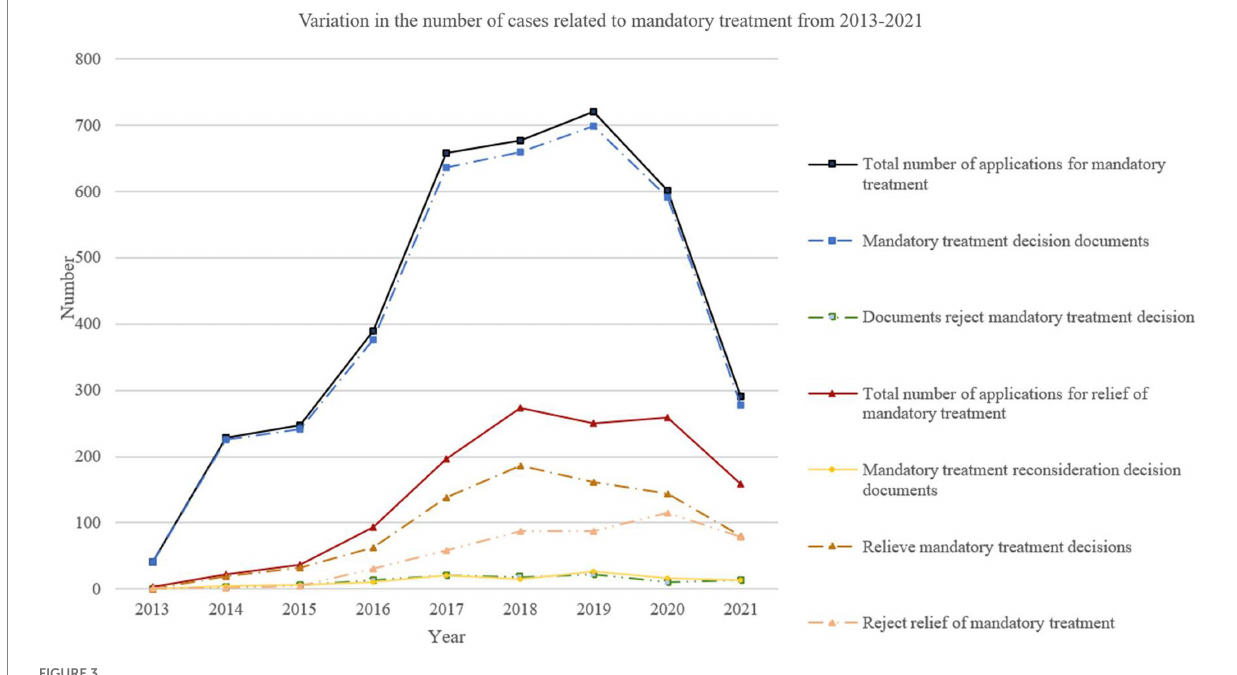
FIGURE 3 Variation in the number of mandatory treatment-related documents from 2013 and